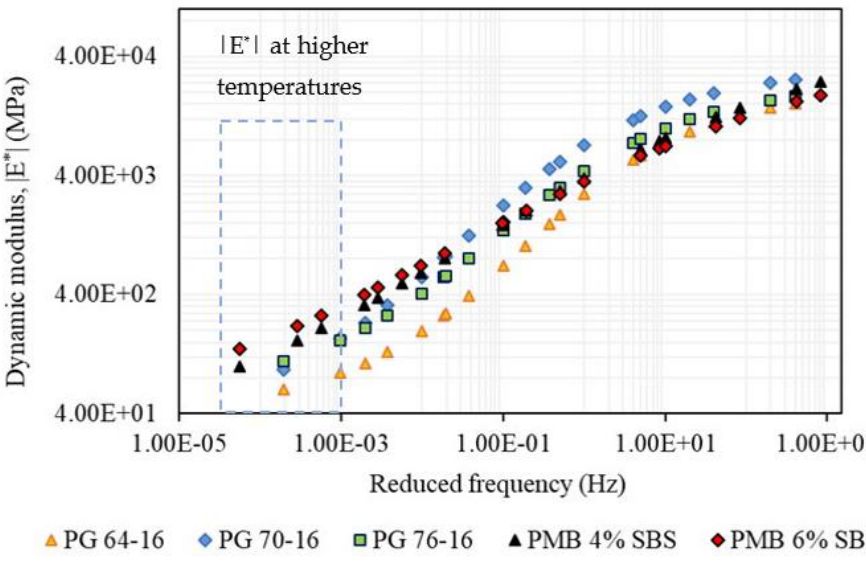
Figure 5. Dynamic Modulus master curves for the five mixes.